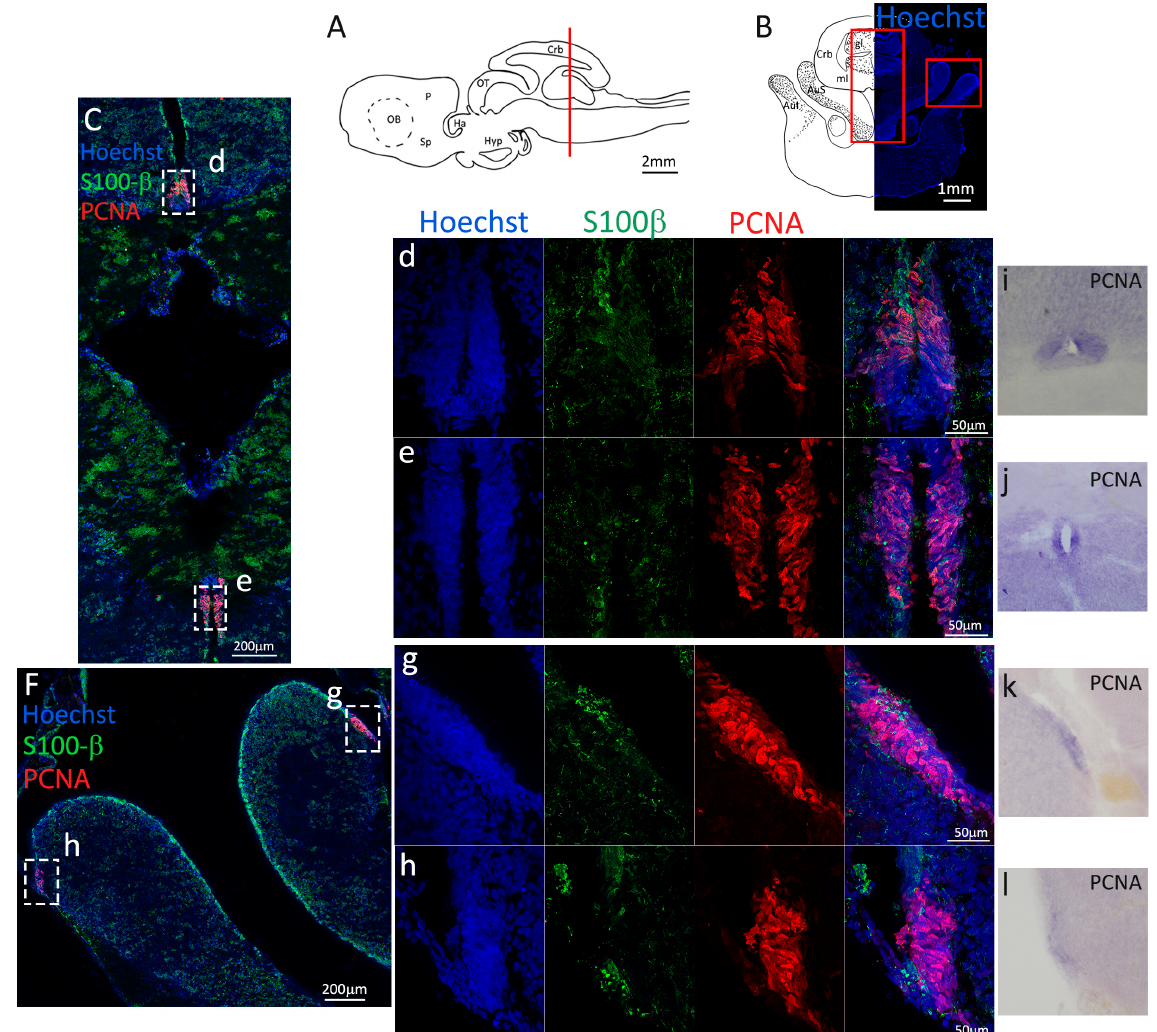
Figure 17. Localization of PCNA (red) and S100 β (green) positive cells in the cerebellum of S. canicula . ( A ) Sagittal representation of S. canicula brain. The red line indicates the rostro-caudal localization of the section represented in the panel. ( B ) Coronal map of the area imaged. On the right, a real coronal section is stained with Hoechst 33342 to show nuclei distribution; on the left, a cartoon is drawn to indicate anatomical references. Red rectangles identify the general area from which images are taken. ( C ) Neurogenic niche of the cerebellum and medial dorsal auricle. ( d ) Magnification of the neurogenic niche localized in the ventral cerebellum. ( e ) Magnification of the neurogenic niche localized in the medial superior cerebellar auricle. ( F ) Lateral neurogenic niches of the cerebellar auricles. ( g ) Lateral neurogenic niche of the superior auricle. ( h ) Neurogenic niche of the inferior auricle. ( i – l ) In situ hybridization for S. canicula pcna in the cerebellum and cerebellar auricles. Abbreviations: Crb: cerebellum, gl: granular layer, ml: molecular layer, AuS: superior cerebellar auricle, AuI: inferior cerebellar auricle.